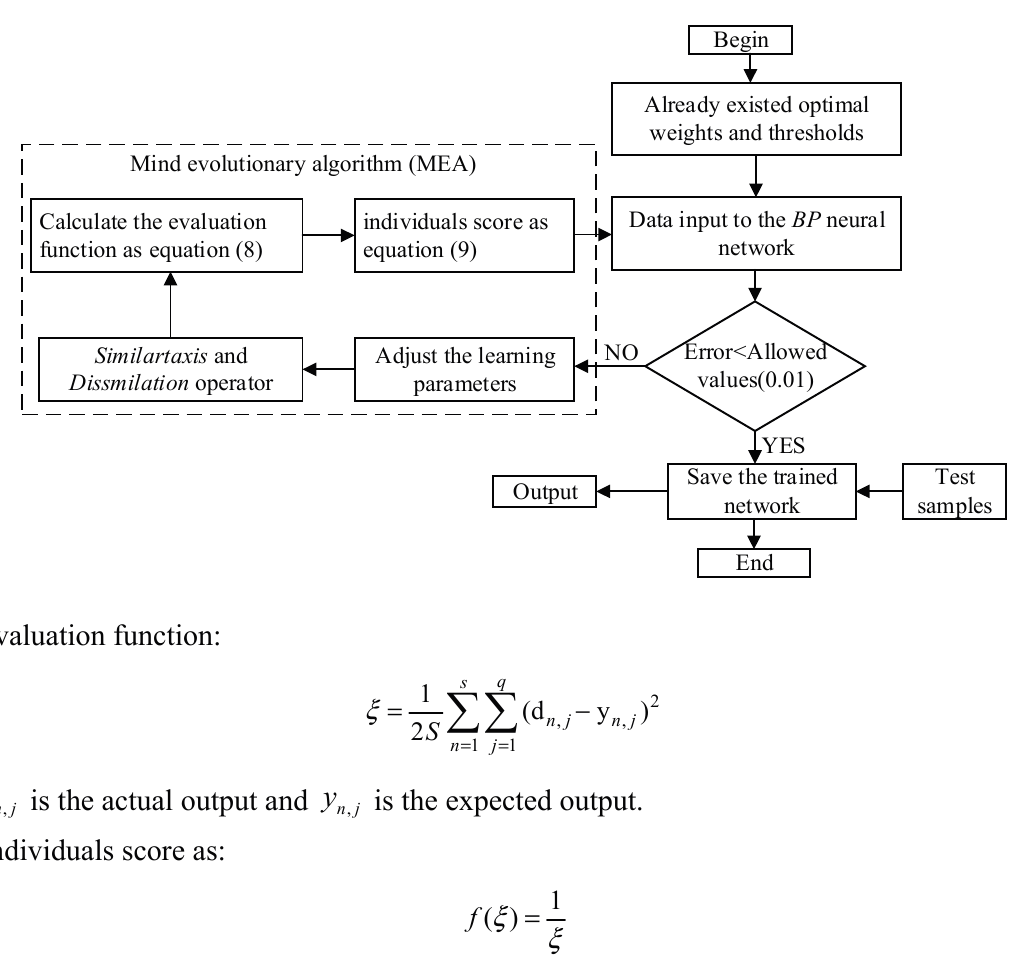
Figure 4. The flow chart of the BP algorithm optimized by